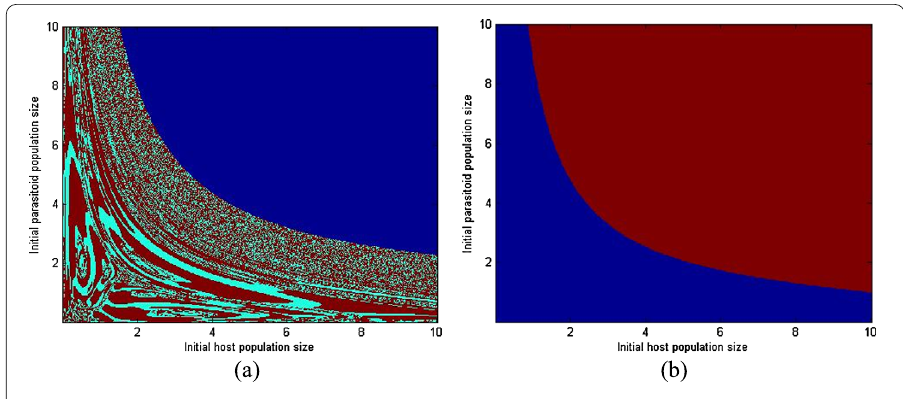
Figure 4 The basins of attraction for non-unique attractors, the scopes of initial values ( x 0 and y 0 ): (0,10]. ( a ) Host-parasitoid system without Allee effect for the host ( m = 0, n = 0): the blue, sky blue, and brown areas are the basins of attraction for chaotic, period-3, and period-6; ( b ) host-parasitoid system incorporating Allee effect ( m = 0.01, n = 0.01): the blue area: the basins of chaotic; brown area:the basins of period-1